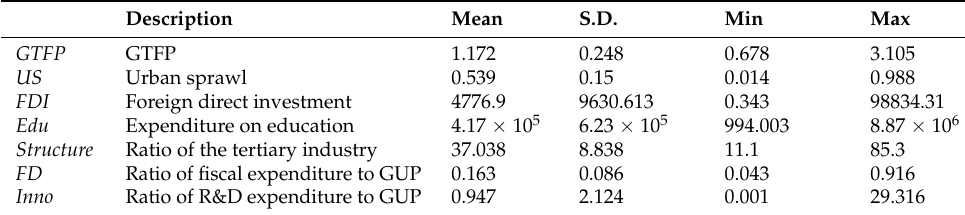
Table 1. Descriptive statistics for the variables in this